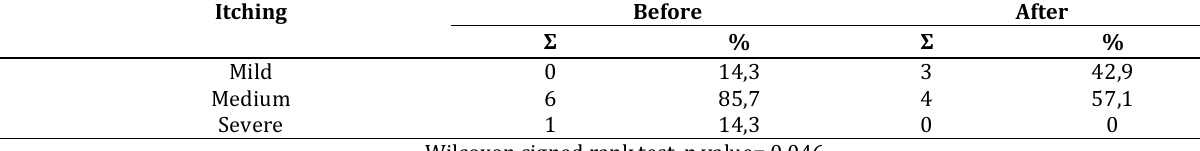
Table 2. Cross-tabulation between the itching before and after being given virgin olive oil in the treatment group